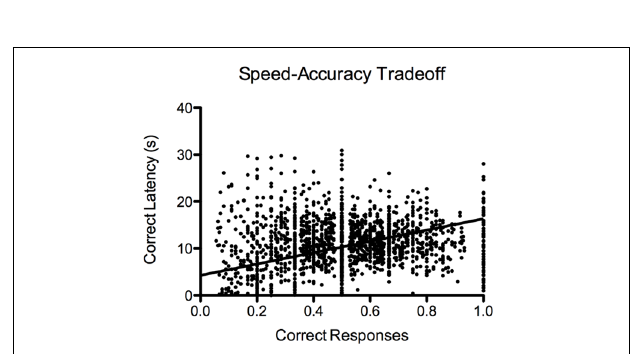
FIGURE 8 | Speed-accuracy trade-off. Proportion of correct responses plotted against approach latency (s) during 5-CSRTT training. This provides evidence for a speed-accuracy trade-off during training, where the fish were more accurate when they waited prior to making a response. Note: N = 60